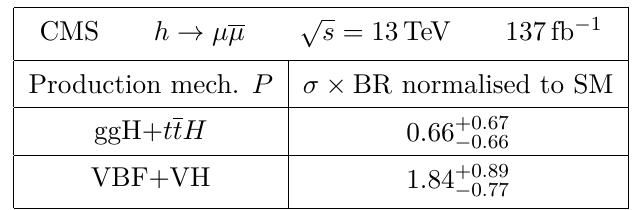
The Higgs signal strength parameter for h → µµ from CMS collaboration in ref. [69]. The production mechanisms are a combination of ggF and ttH in the first row, and of VBF and VH in the